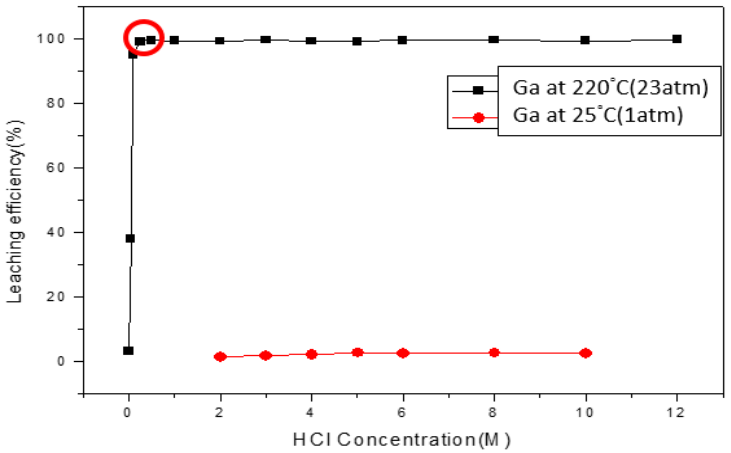
Figure 7. Effect of HCl concentration on the leaching efficiency of gallium at liquid-solid ratio 50 (mL/g) at 25 °C (1 atm) and 220 °C (23 atm) for 4 h respectively.